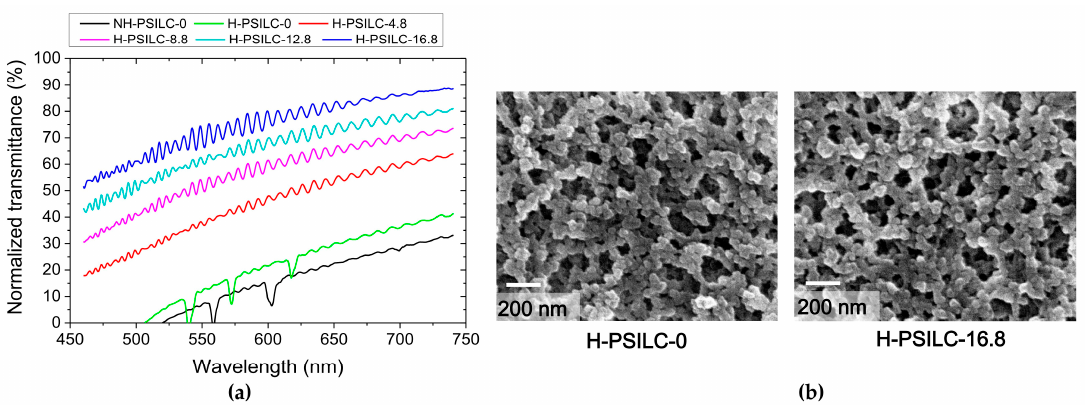
Figure 3. ( a ) Comparisons of normalized transmittance spectra in PSILC cells with various ratios of the ingredients listed in Table 1. Both NH-PSILC-0 and H-PSILC-0 cells without S811 chiral dopant were compared in terms of transmittance spectra with individual non-holographic and holographic exposure processes; ( b ) Comparisons of polymer network morphology by SEM images in both PSILC cells with and without S811 chiral dopant.